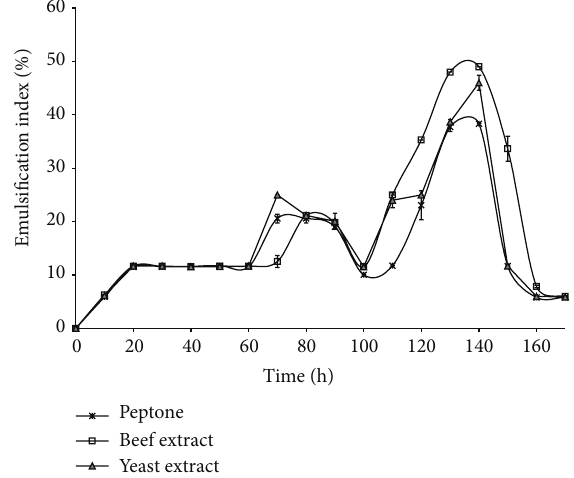
Figure 2: Selection of nitrogen source—one factor at a